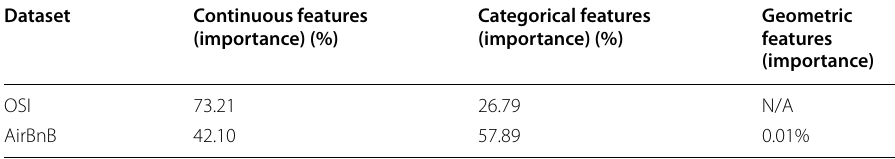
Table 15 Importance/weightage assigned by distributed FCMD-MD to each feature type Dataset